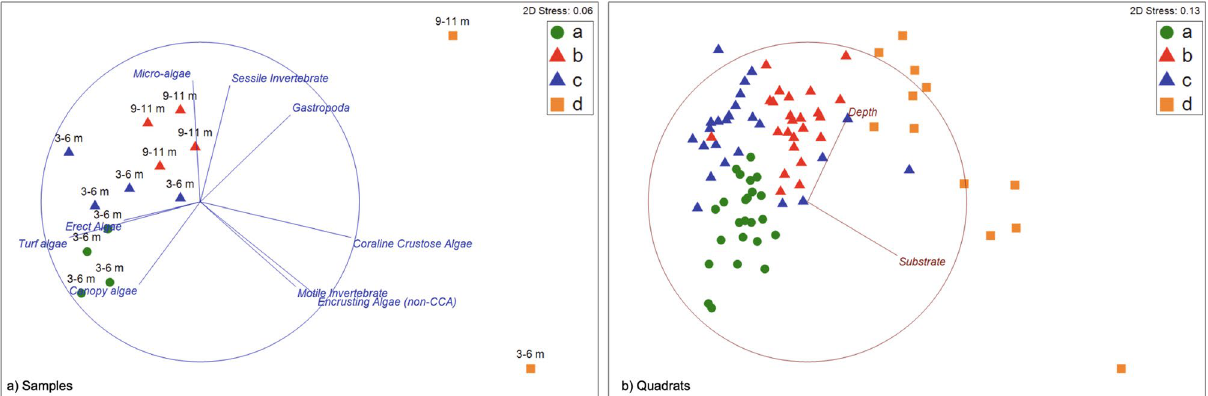
Figure 4. Non-metric Multidimensional Scaling plots of Bray–Curtis similarity ordinations of samples and (left) and quadrats (right) labelled by organism assemblage (top right corner); ( a ) Photoquadrat Survey Samples (n = 14) with correlation vectors of major taxonomic groups (overlay in blue lines), and; ( b ) Individual Quadrats (n = 84) with correlation vectors of normalised variation in Depth and Substrate categories groups (overlay in red lines). Figure generated in PRIMER v7 (with PERMANOVA